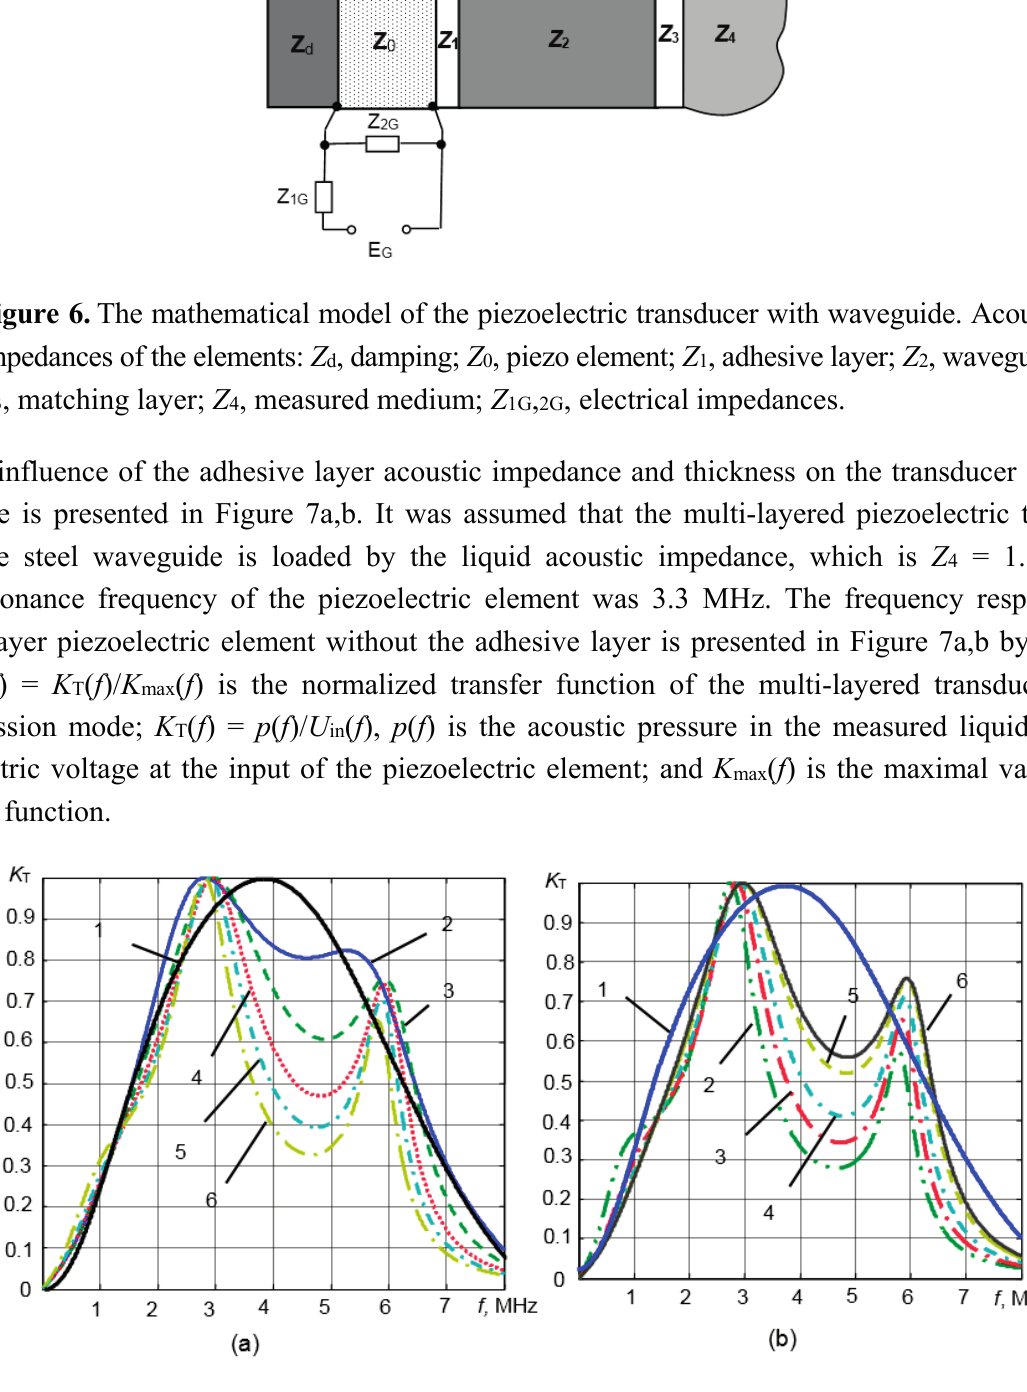
Figure 7. ( a ) Calculated influence of the adhesive layer thickness d 1 on transducer frequency responses: 1, single-layer piezoelectric transducer; 2, 0 μ m; 3, 10 μ m; 4, 20 μ m; 5, 30 μ m; 6, 50 μ m; ( b ) Influence of the adhesive layer acoustic impedance Z 1 on transducer frequency responses: 1, single-layer piezoelectric transducer; 2, 2 MRayl; 3, 3 MRayl; 4, 4 MRayl; 5, 6 MRayl; 6, 7